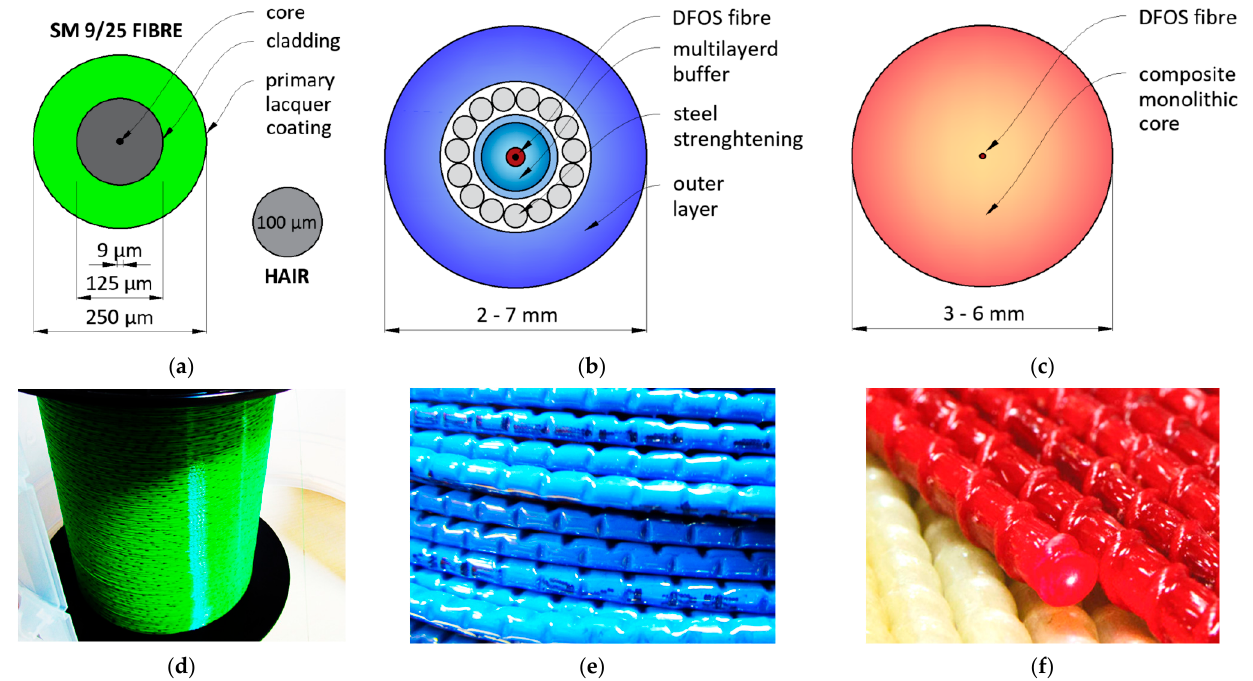
Figure 3. Example cross-sections of ( a ) single-mode optical fibre in its primary coating, ( b ) layered sensing cable with steel strengthening insert and ( c ) monolithic strain sensor with the corresponding views of their external surfaces ( d – f ).